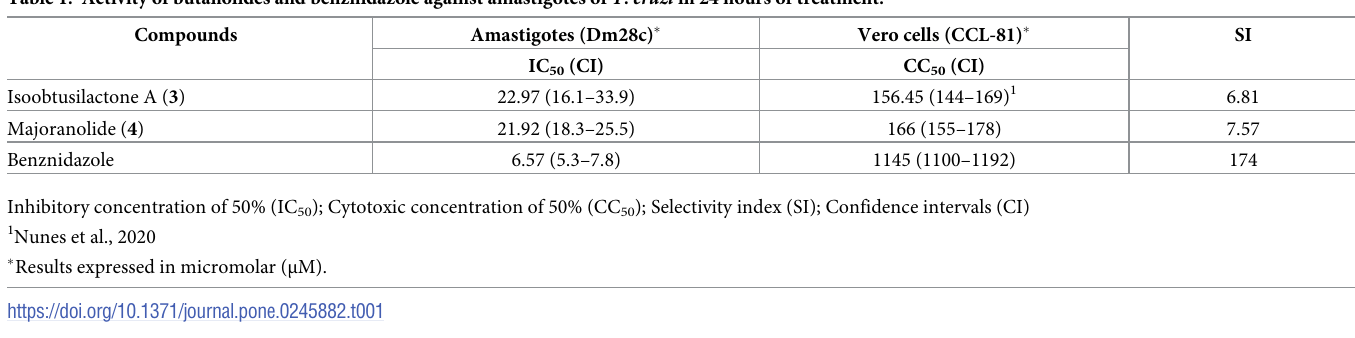
To predict the effect of interaction between active butanolides on amastigote cells (Fig 2), the combination index (Ci) was determined. According to the theorem of Chou-Talalay, Ci = 1 indicates an additive effect, Ci < 1 indicates synergism, and Ci > 1 indicates antago- nism, based on Ci, synergism can be further subclassified as: nearly additive (0.9–1), slight syn-